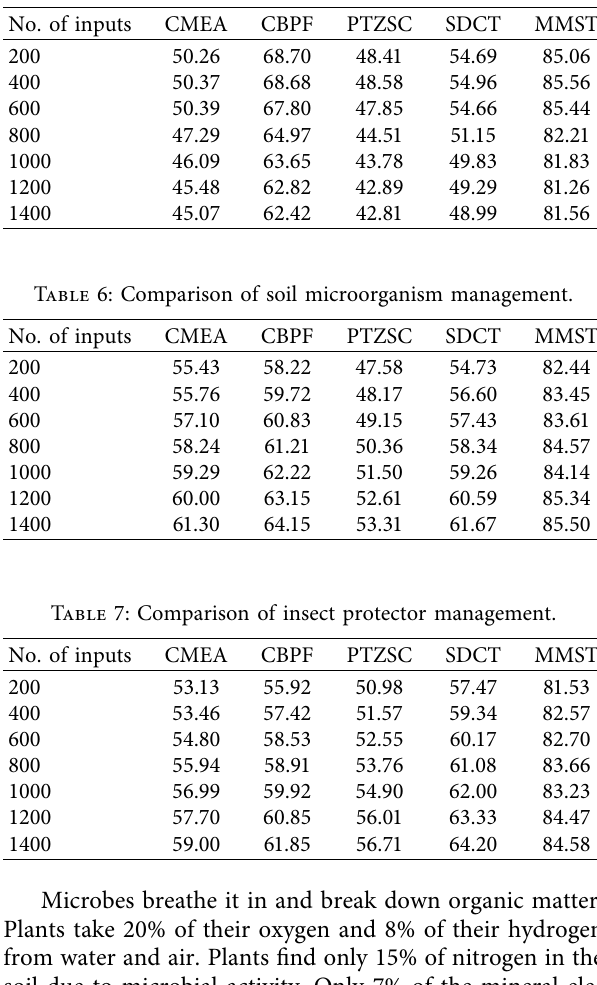
Table 5: Comparison of plant nutrition management.